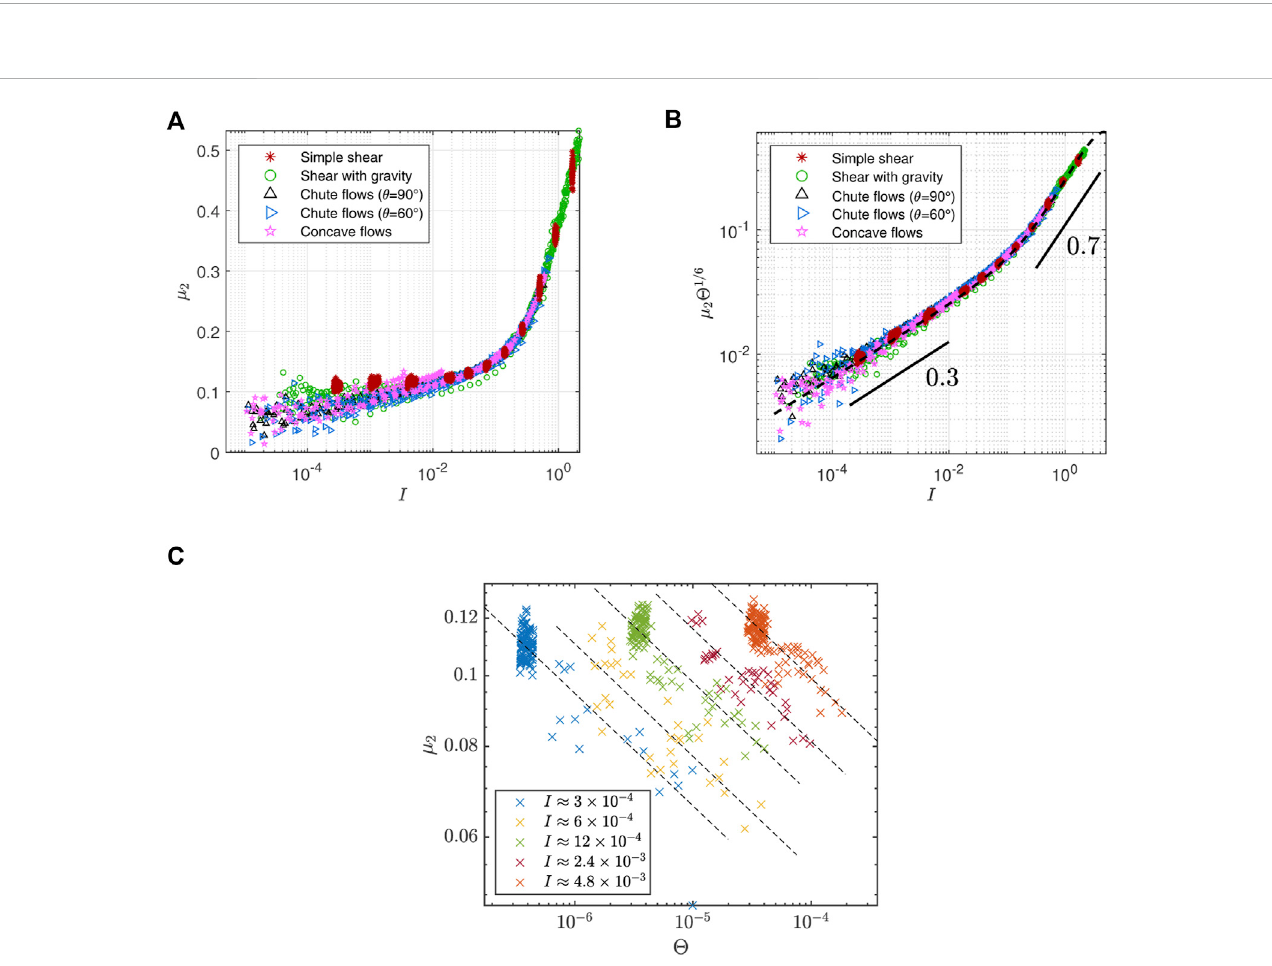
FIGURE 5 (A) μ 2 vs. I in DEM simulations of planar shear fl ows. Scattered data indicate μ 2 is not a function of I alone. (B) Rescaling μ 2 by Θ p 2 seems to collapse data into a master curve when p 2 ≈ 1/6: μ 2 Θ 1/6 = f 2 ( I ). Dashed trend line is f 2 ( I ) used for the FDM simulations in Section 3. (C) Using multivariate linear regression for fi veselected panels of I , theexponentof μ 2 ismeasuredas 0.154 ± 0.014 (theslopemagnitude ofdashedlines) for 3Dsphereswith from the selected data set, the actual error could be